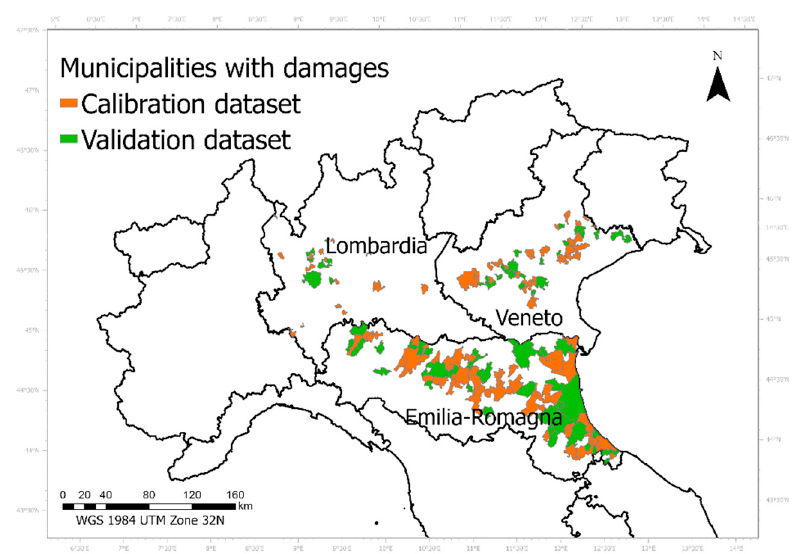
Figure 4. Municipalities considered for the model calibration and validation.